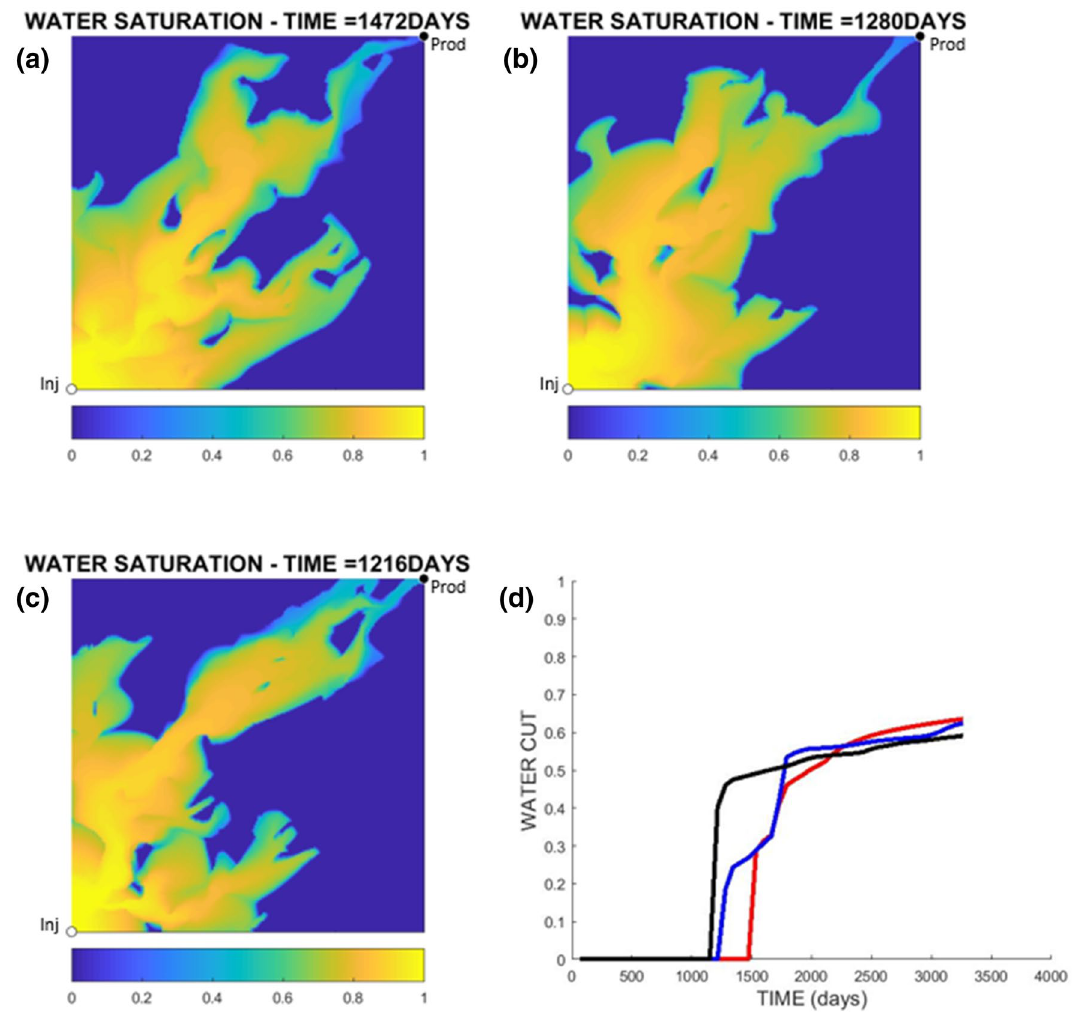
Fig. 11 a DR1 ( t = 0) saturation map at breakthrough. b DR2 ( t = 0.5) saturation map at breakthrough. c DR3 ( t = 1) saturation map at break- through. d Water cuts simulated for DR1 (red), DR2 (blue) and DR3